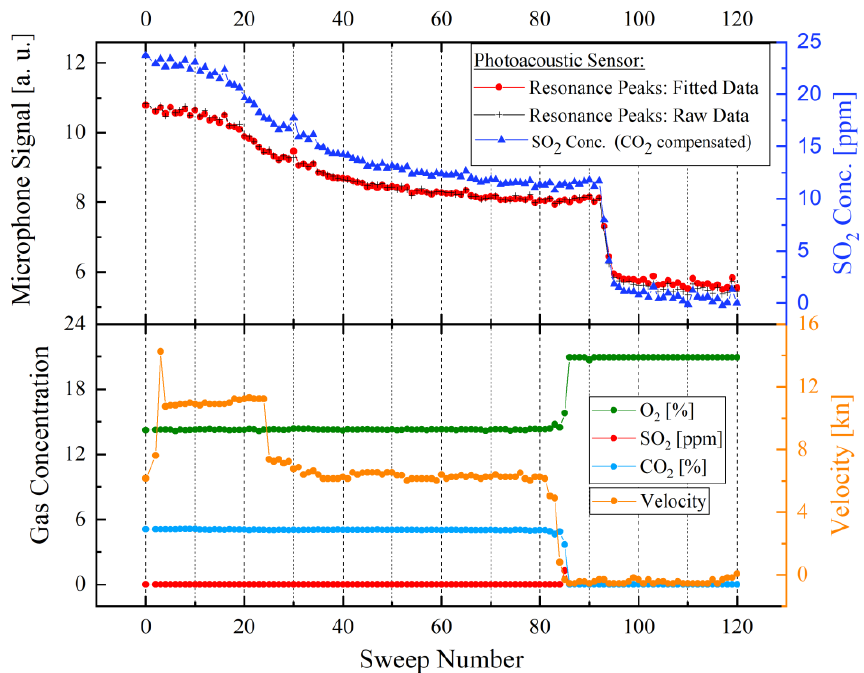
Figure 10. Measured raw data during container ship navigation. The upper diagram shows two different analysis methodologies of the measured data (red and black curve) by the developed SO 2 sensor and the corresponding SO 2 concentration in ppm after compensating the influence of CO 2 on the detected signal (dark blue curve). The red curve in the upper diagram represents the data calculated through the instantaneous fitting process (via analysis electronics) of the measured data set, while the black diagram (with black crosses) corresponds to the subsequent manual analysis of the gathered data. The lower diagram shows the measured data by the IMR 7500 reference gas analyzer, which includes CO 2 , O 2 , SO 2 concentrations and the measured velocity (kn ~0.514 m/s) of the container ship. At about sweep number 85 the engine is turned off, which results in the increase in the O 2 concentration and a simultaneous reduction of the CO 2 concentration. Subsequently, the measured SO 2 concentration dependent microphone signal of the newly developed photoacoustic gas sensor reaches — with a delay at sweep number 90 caused by the additional gas volume of the tube connections — the lowest values.